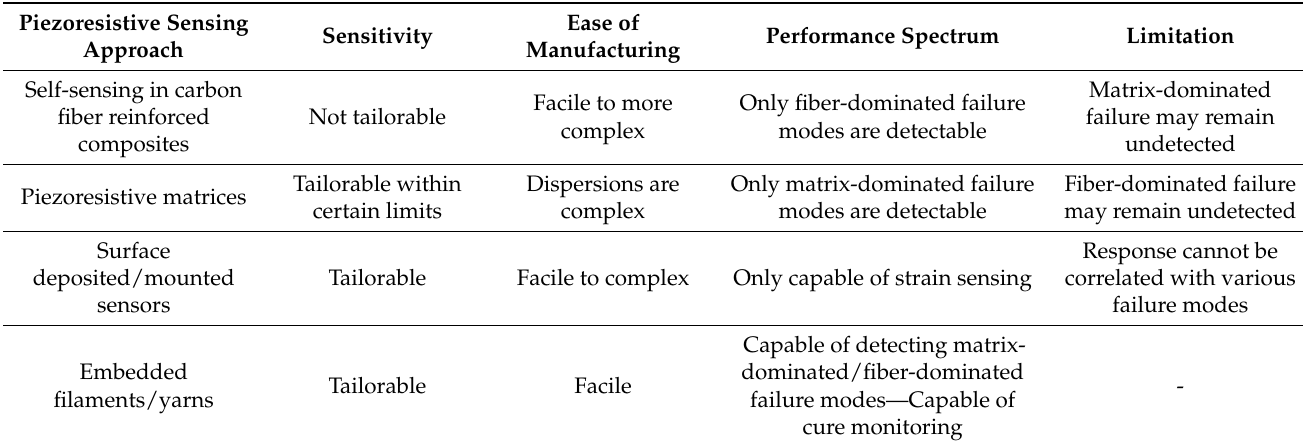
Table 1. Comparative analysis of the four piezoresistive sensing approaches on the basis of adopted selection strategy. Piezoresistive